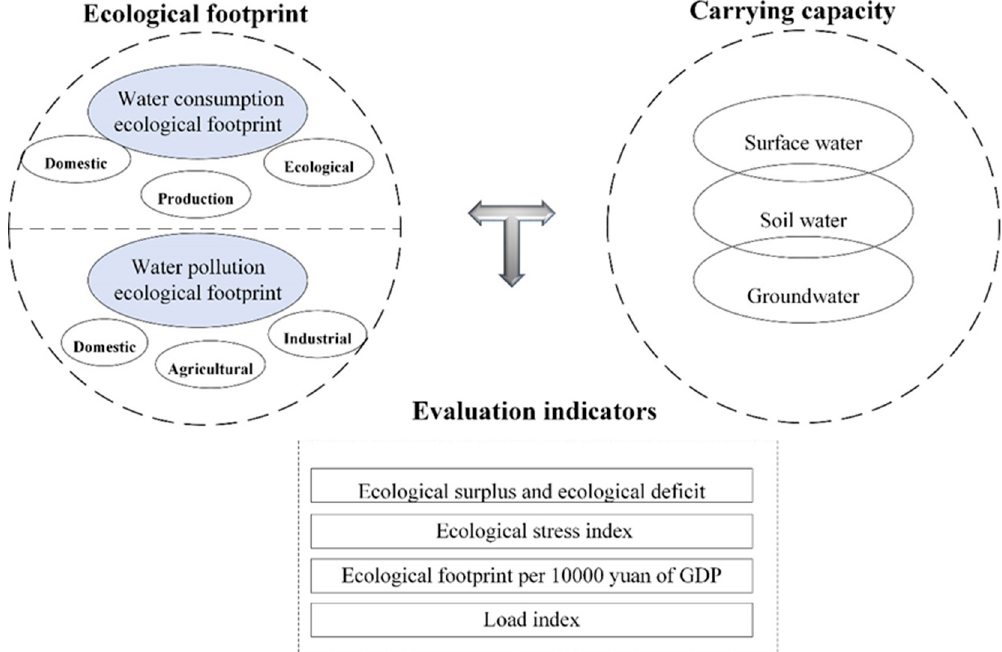
Figure 2. Water resources utilization assessment model framework.